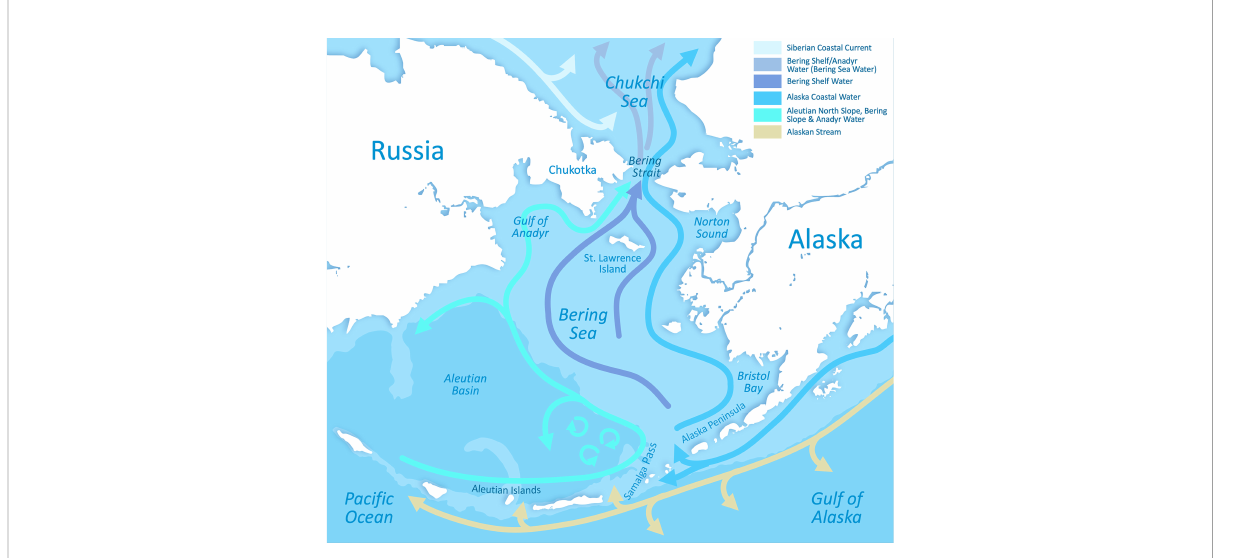
FIGURE 1 Aleutian Islands and Bering Sea region, showing water masses and prevailing direction of fl